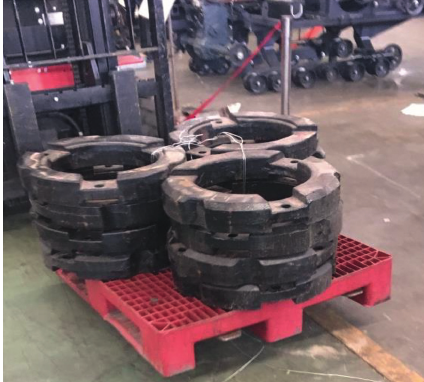
Figure 11: Counterweight block for driving stability of the rice combine harvester.